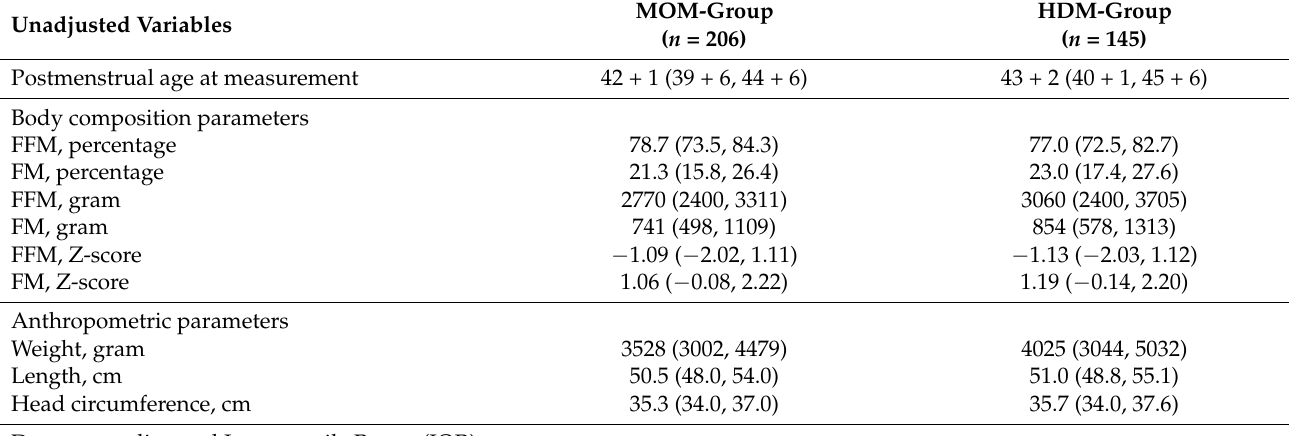
Table 3. Unadjusted anthropometric parameters and body composition parameters at term-equivalent